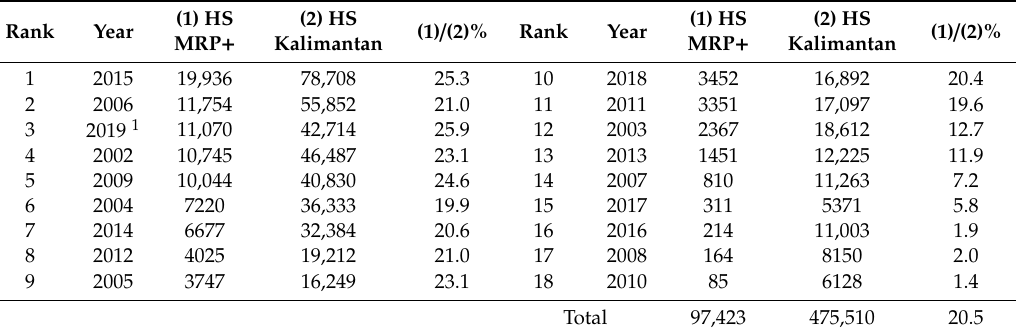
Table 2. Annual number of hotspots in the study are (MRP + ) and whole